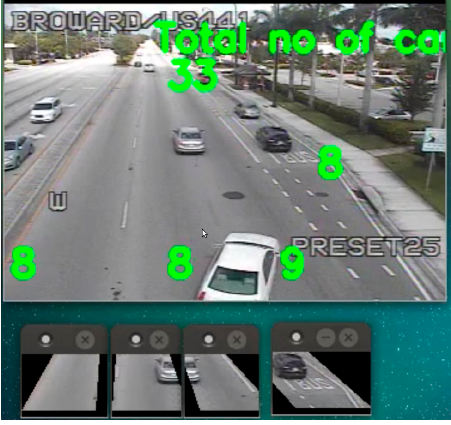
Figure 9. The double counting issue, when a car moves between two RIOs.